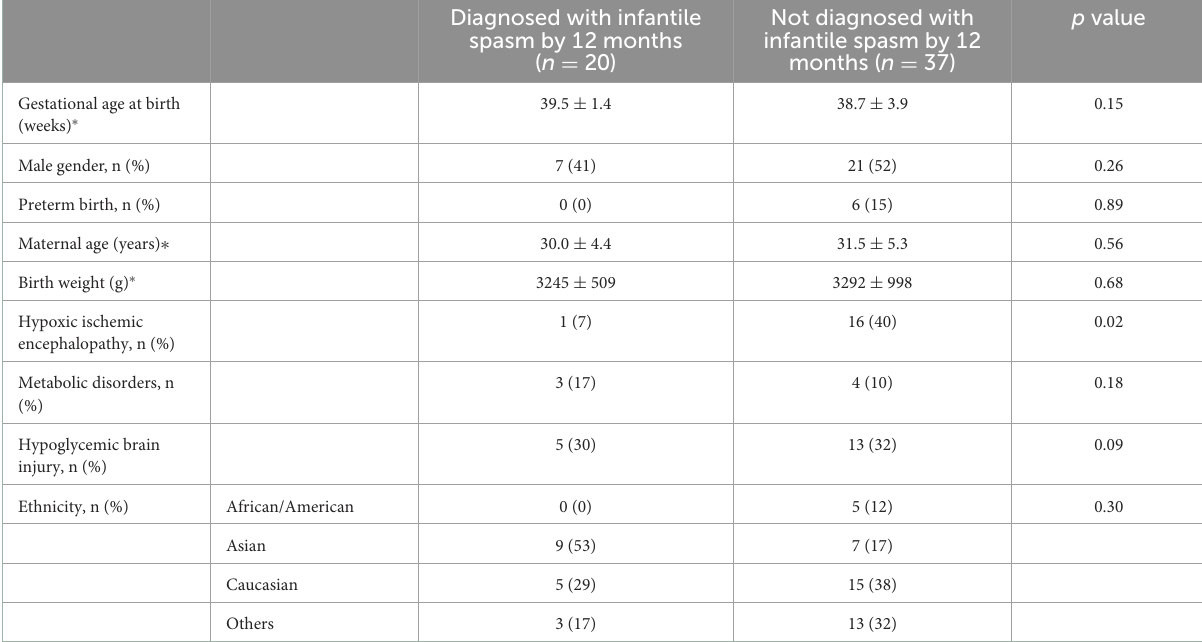
TABLE 1 Clinical characteristics of the study population.